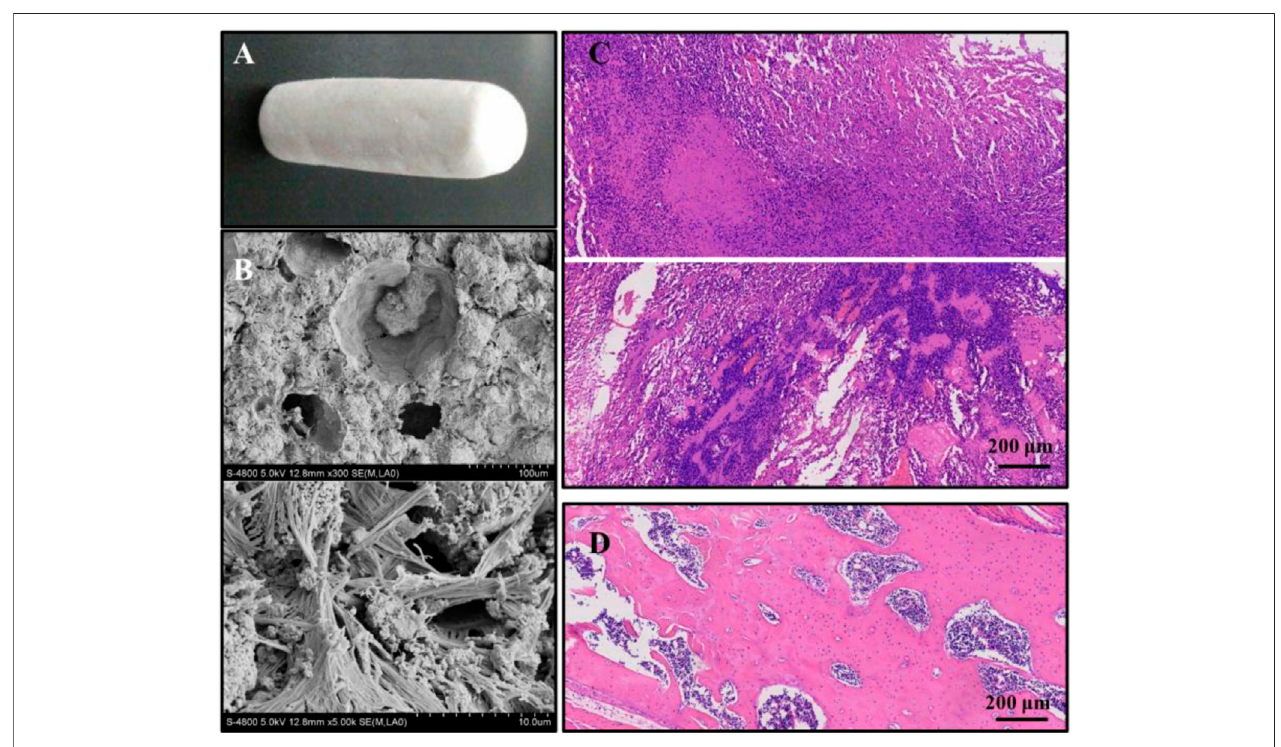
FIGURE 2 | (A) Macroscopic structures of collagen-thermosensitive hydrogel-calcium phosphate (CTC) composites; (B) microscopic structures by magni fi cation 300 and 5000 times of CTC composites; (C) osteosarcoma models were successfully constructed by 4-HAQO, bar: 200 μ m; (D) control group without tumors, bar: 200 μ